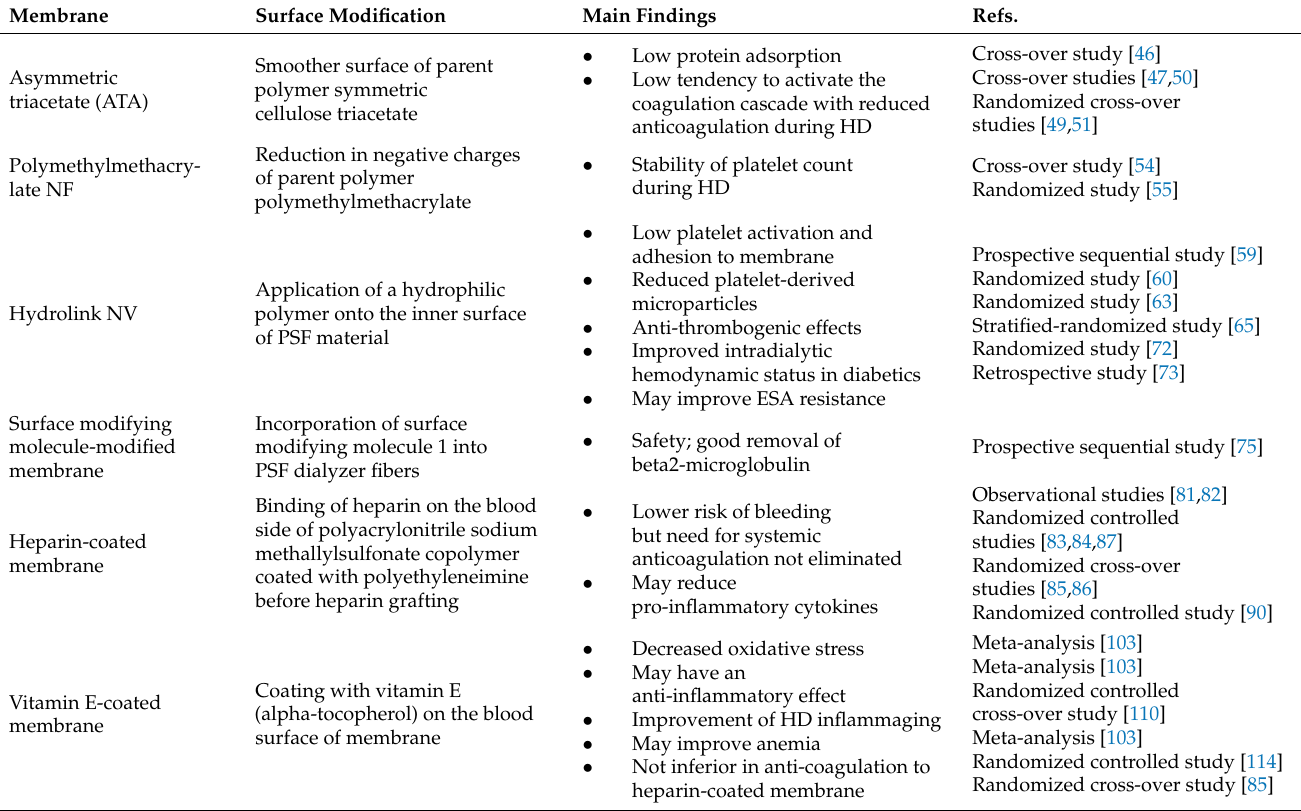
Table 2. Summary of clinical studies on surface-modified membranes for hemodialysis. Membrane Surface Modification Main Findings